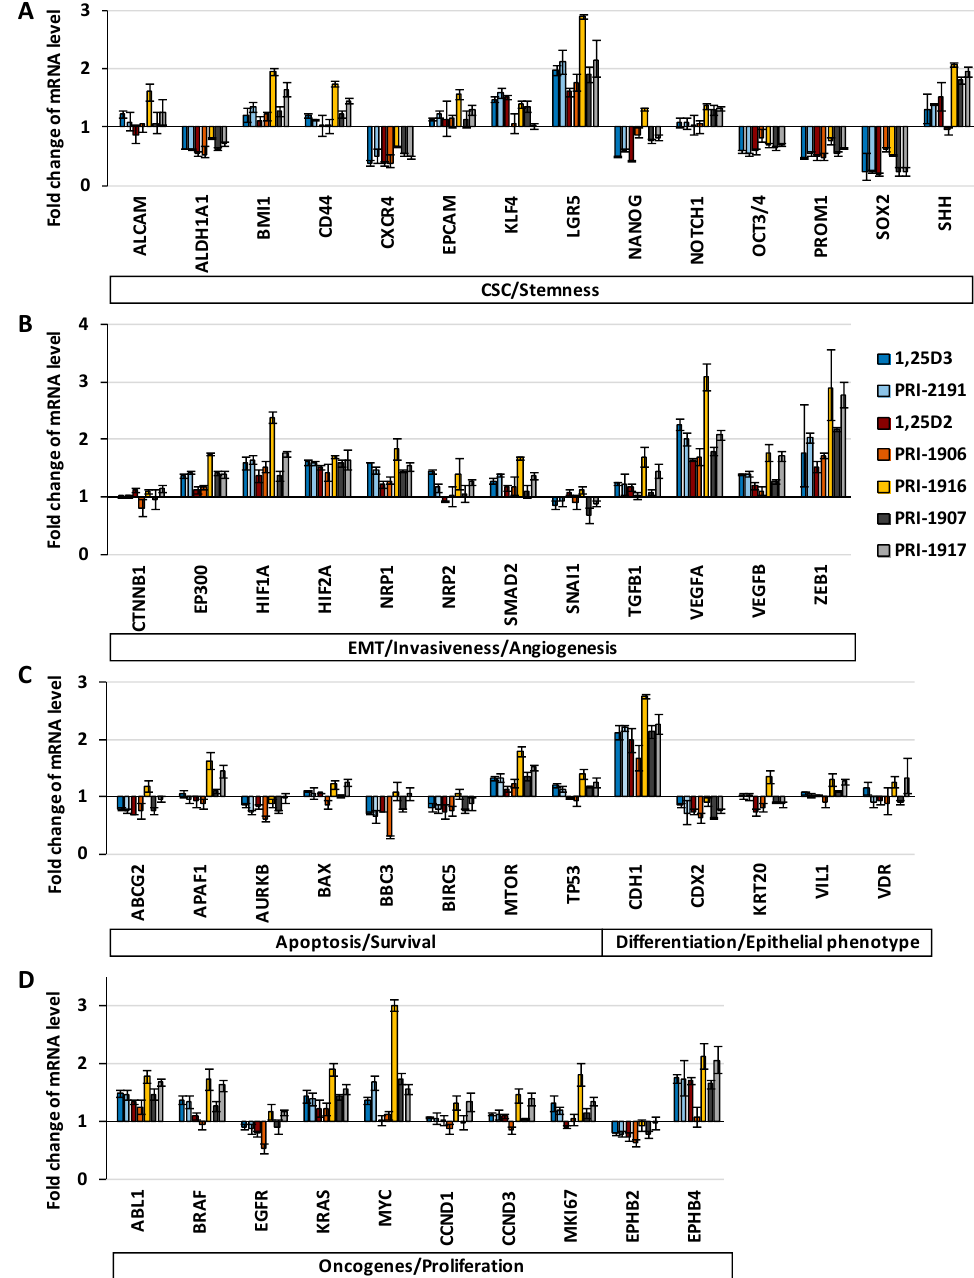
Figure 5. Comparison of the regulatory effects of 1,25D2, 1,25D3, and their analogues on gene expression in HT-29/5-FU cells undergoing renewal during four-day culture after cell passage. The graphs show fold change of the relative mRNA expression level of genes related to ( A ) cancer stem cells (CSC), stemness; ( B ) endothelial-mesenchymal transition (EMT), invasiveness, angiogenesis; ( C ) apoptosis, survival, differentiation and epithelial phenotype; ( D ) oncogenesis and proliferation in HT-29/5-FU exposed to vitamin D analogue (100 nM) for four days after cell passage, as compared to the level in HT-29/5-FU cells cultured in medium only for four days after cell passage. GAPDH was used as an endogenous control. Fold differences were calculated using the ΔΔ C t method and are expressed as a range that is a result of incorporating the standard deviation of the ΔΔ C t value into the fold-difference calculation.